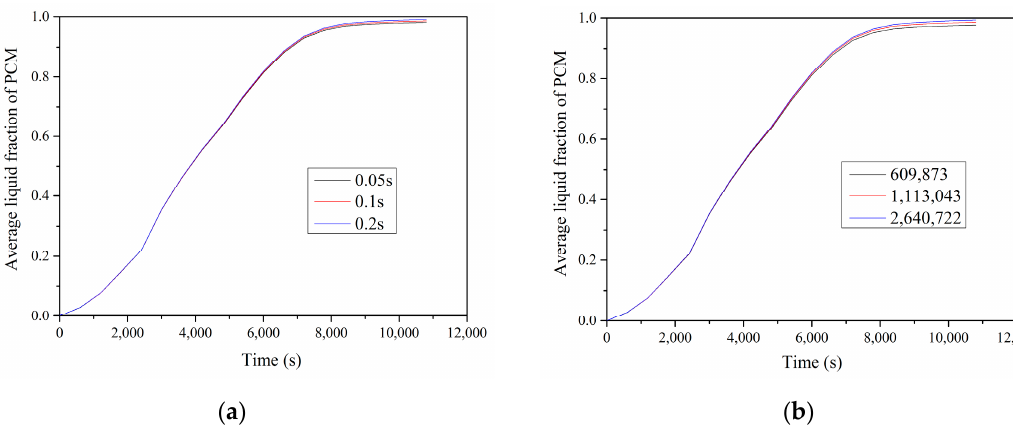
Figure 7. Dependency of the numerical solution. ( a ) Time step with grid size of 1,113,043; ( b ) Grid size with time step of 0.1 s.